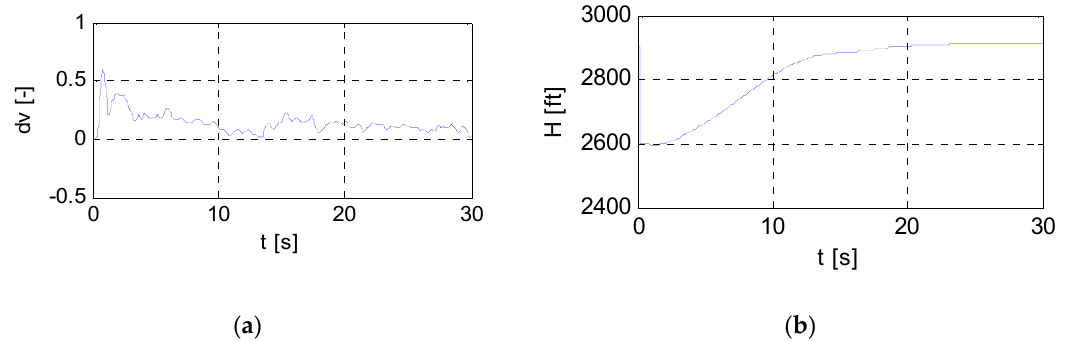
Figure 3. Data representing pilot’s control action (stick deflection) ( a ) and as a response to the initial step change of altitude (perceived input signal) ( b ).